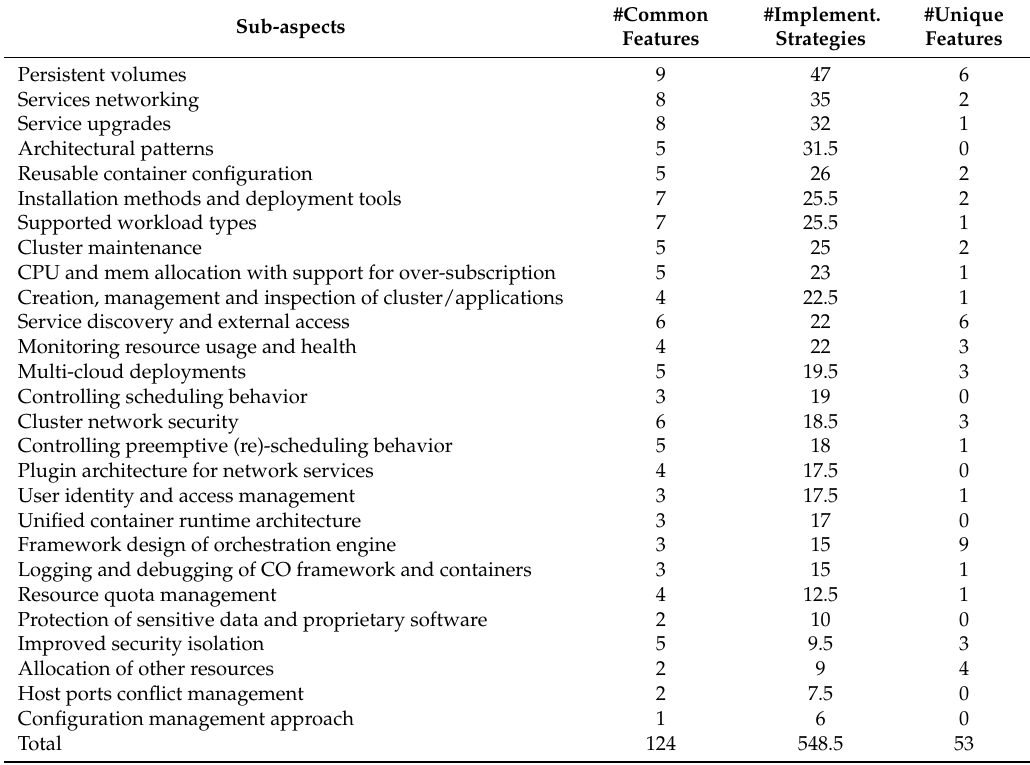
Table 4. Functional sub-aspects ranked according to the number of common feature implementation strategies by CO frameworks. Features that are only partially supported by CO framework or that are only offered by the commercial version are counted as a 1 2